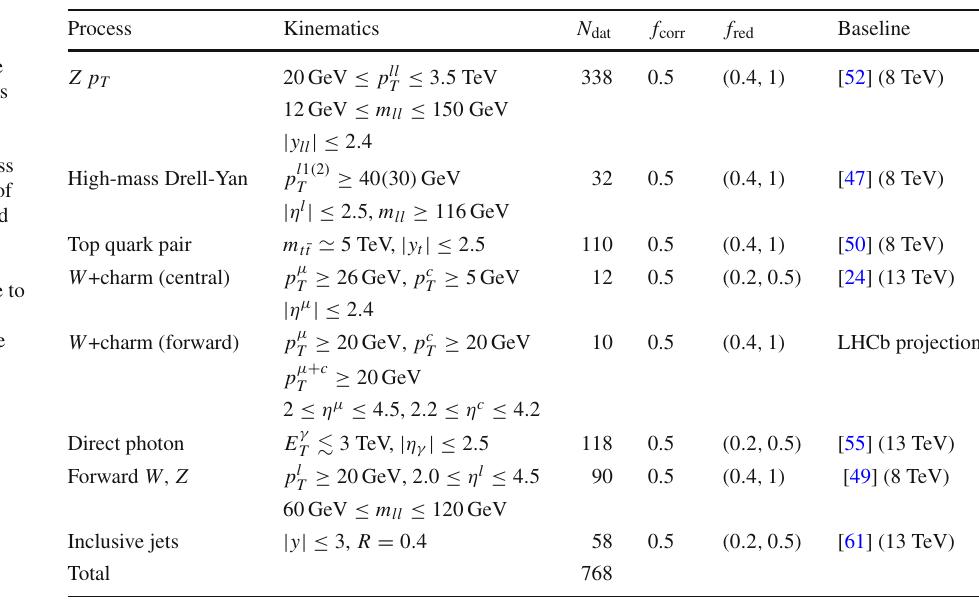
Table 1 Summary of the features of the HL–LHC pseudo–data generated for the present study For each process we indicate the kinematic coverage, the number of pseudo–data points used across all detectors N dat , the values of the correction factors f corr and f red ; and finally the reference from the 8 TeV or 13 TeV measurement used as baseline to define the binning and the systematic uncertainties of the HL–LHC pseudo–data, as discussed in the text